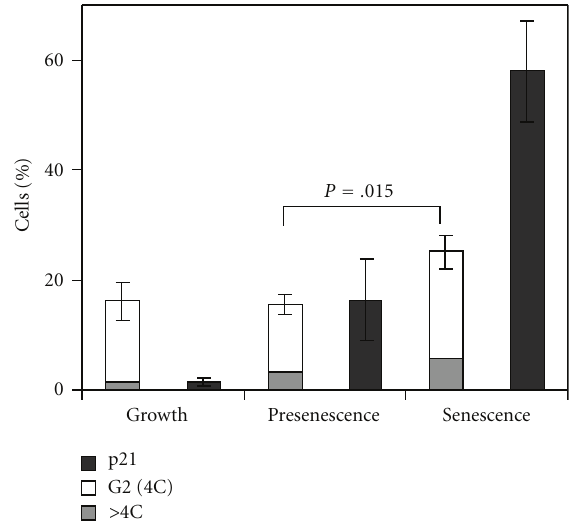
Figure 3: Quantitative data showing changes obtained from the DNA cytometry results, at the growth phase, presenescence, and senescence averaged from all experiments and the corresponding proportions of cells displaying nuclear positivity for p21. Significant increase of the 4C fraction accompany transition from presenes- cence to senescence ( P = . 015). Increase of the proportion of hypertetraploid cells, in parallel to considerable increase of the proportion of p21-positive cells, accompany the whole